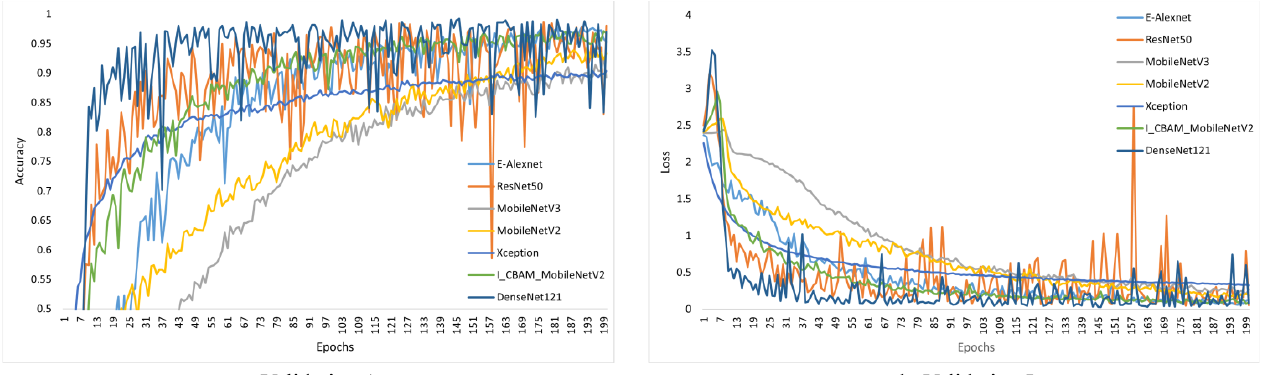
Figure 10. Training accuracy and loss of different models.